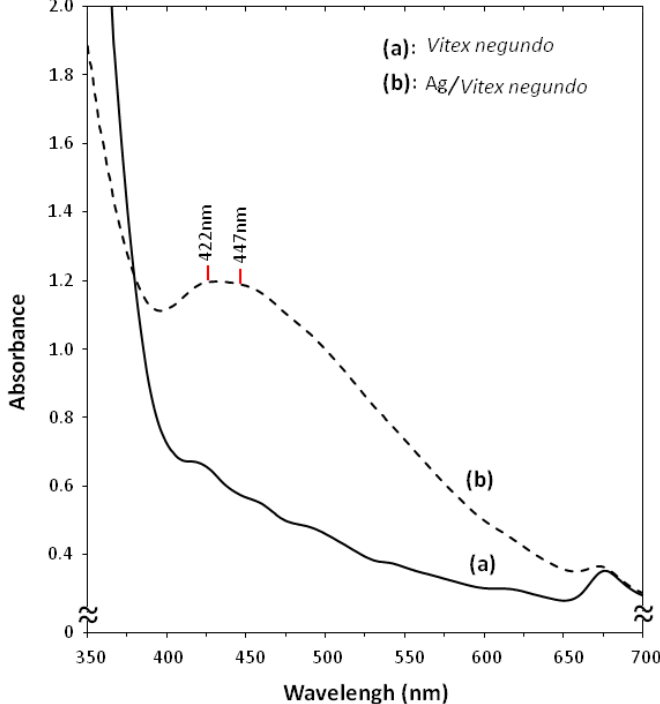
Figure 2. UV-Vis absorption spectra of ( a ) Vitex negundo and ( b ) Ag/ Vitex negundo emulsion after 48 h.